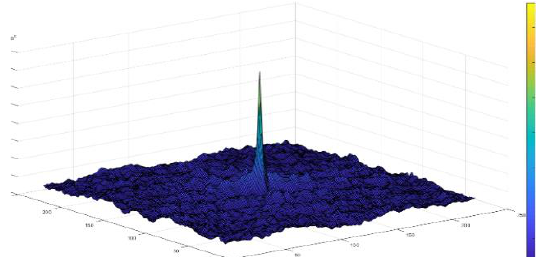
Figure 6. The cross-power spectrum matrix of feature volume